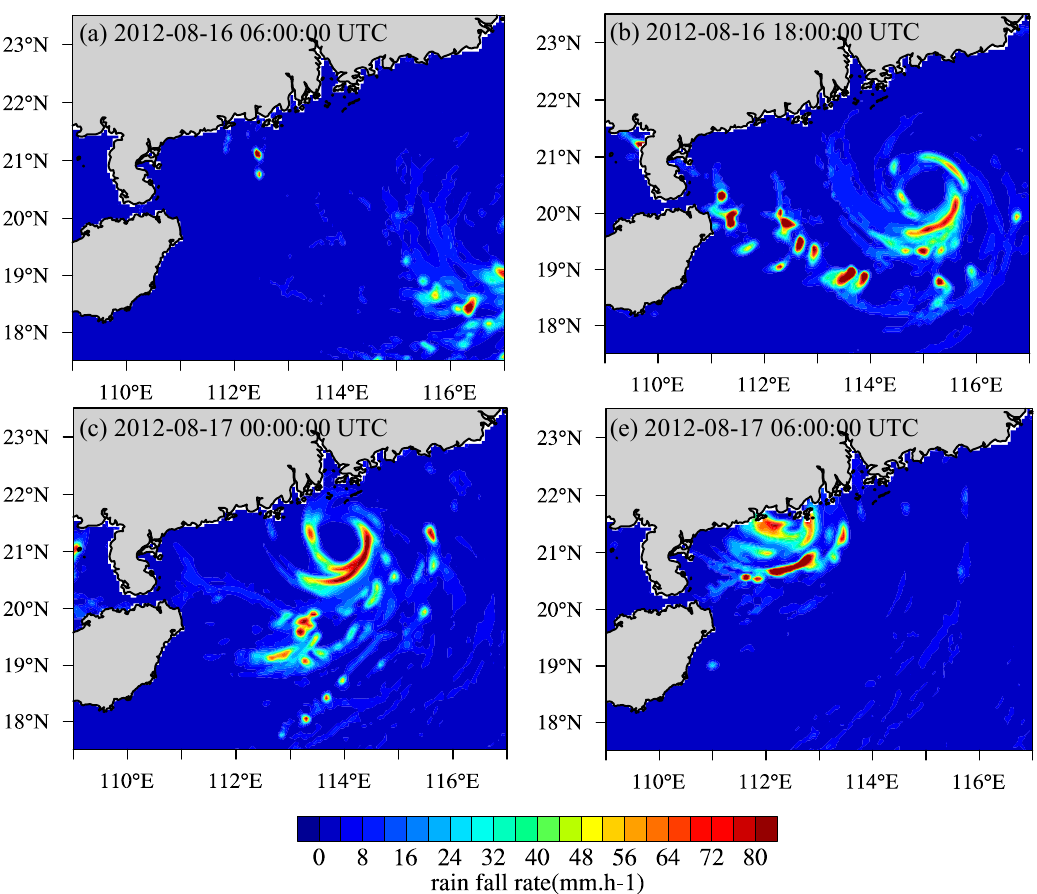
Figure 7. Spatial distribution of the rainfall rate influenced by typhoon Kai-tak.